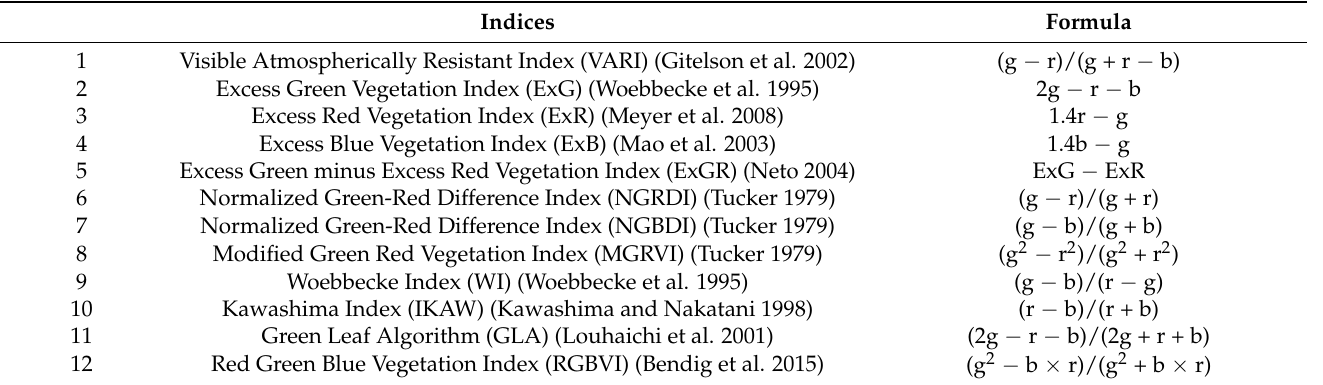
Table 2. Colour indices, formulas, and references.